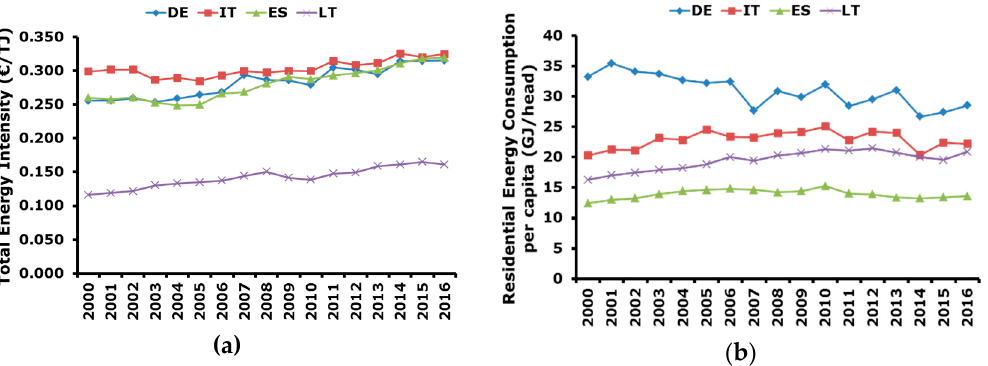
Figure 3. Energy consumption indicators: ( a ) total energy intensity with respect to the GDP (2010 real values); ( b ) residential energy consumption per capita.